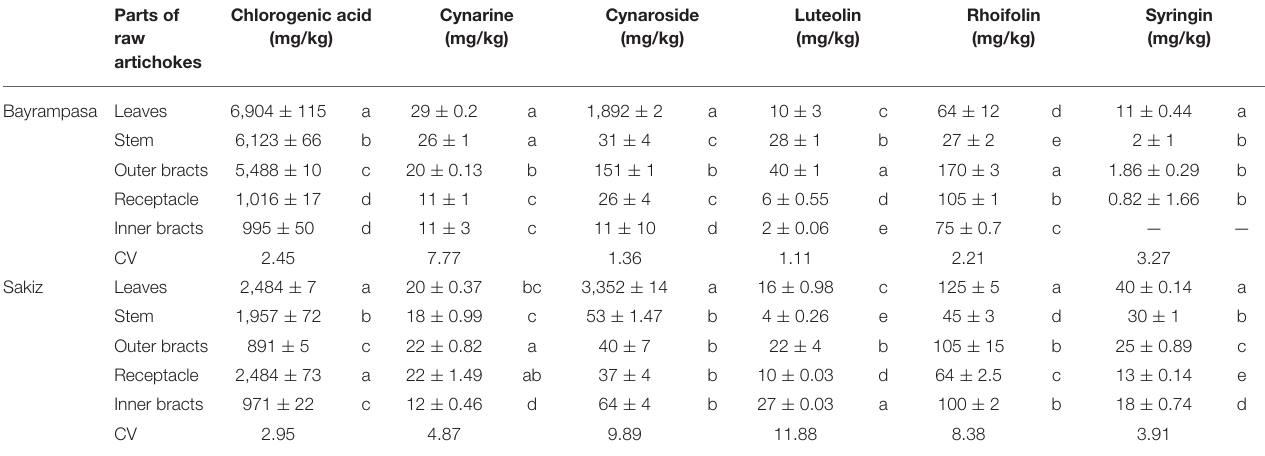
Chlorogenic acid (mg/kg)